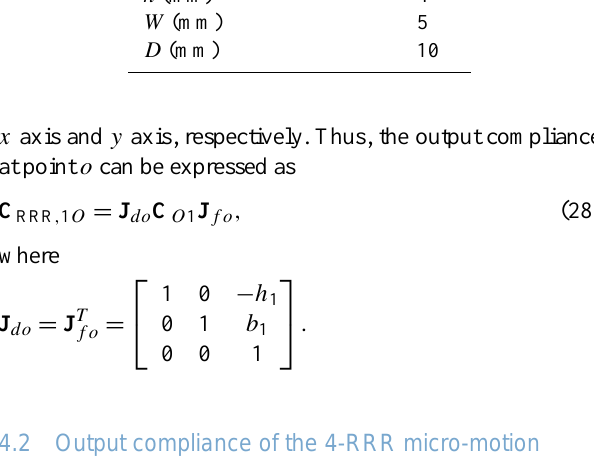
Figure 8. Geometrical dimensions of the constant rectangular cross-section flexure hinge.